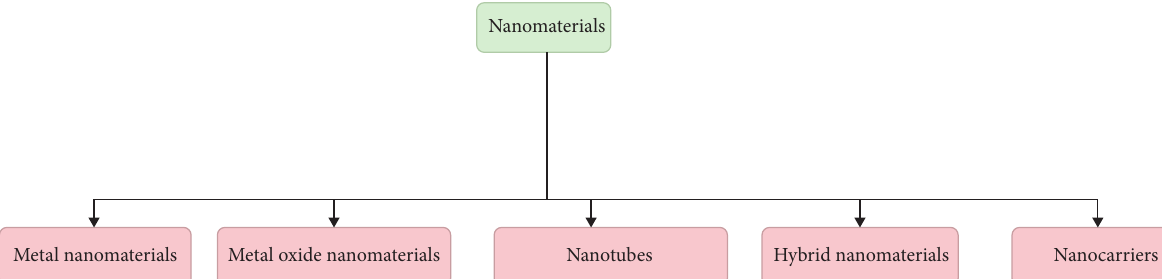
Figure 6: Demonstrates the classification of nanomaterials used in fine chemical